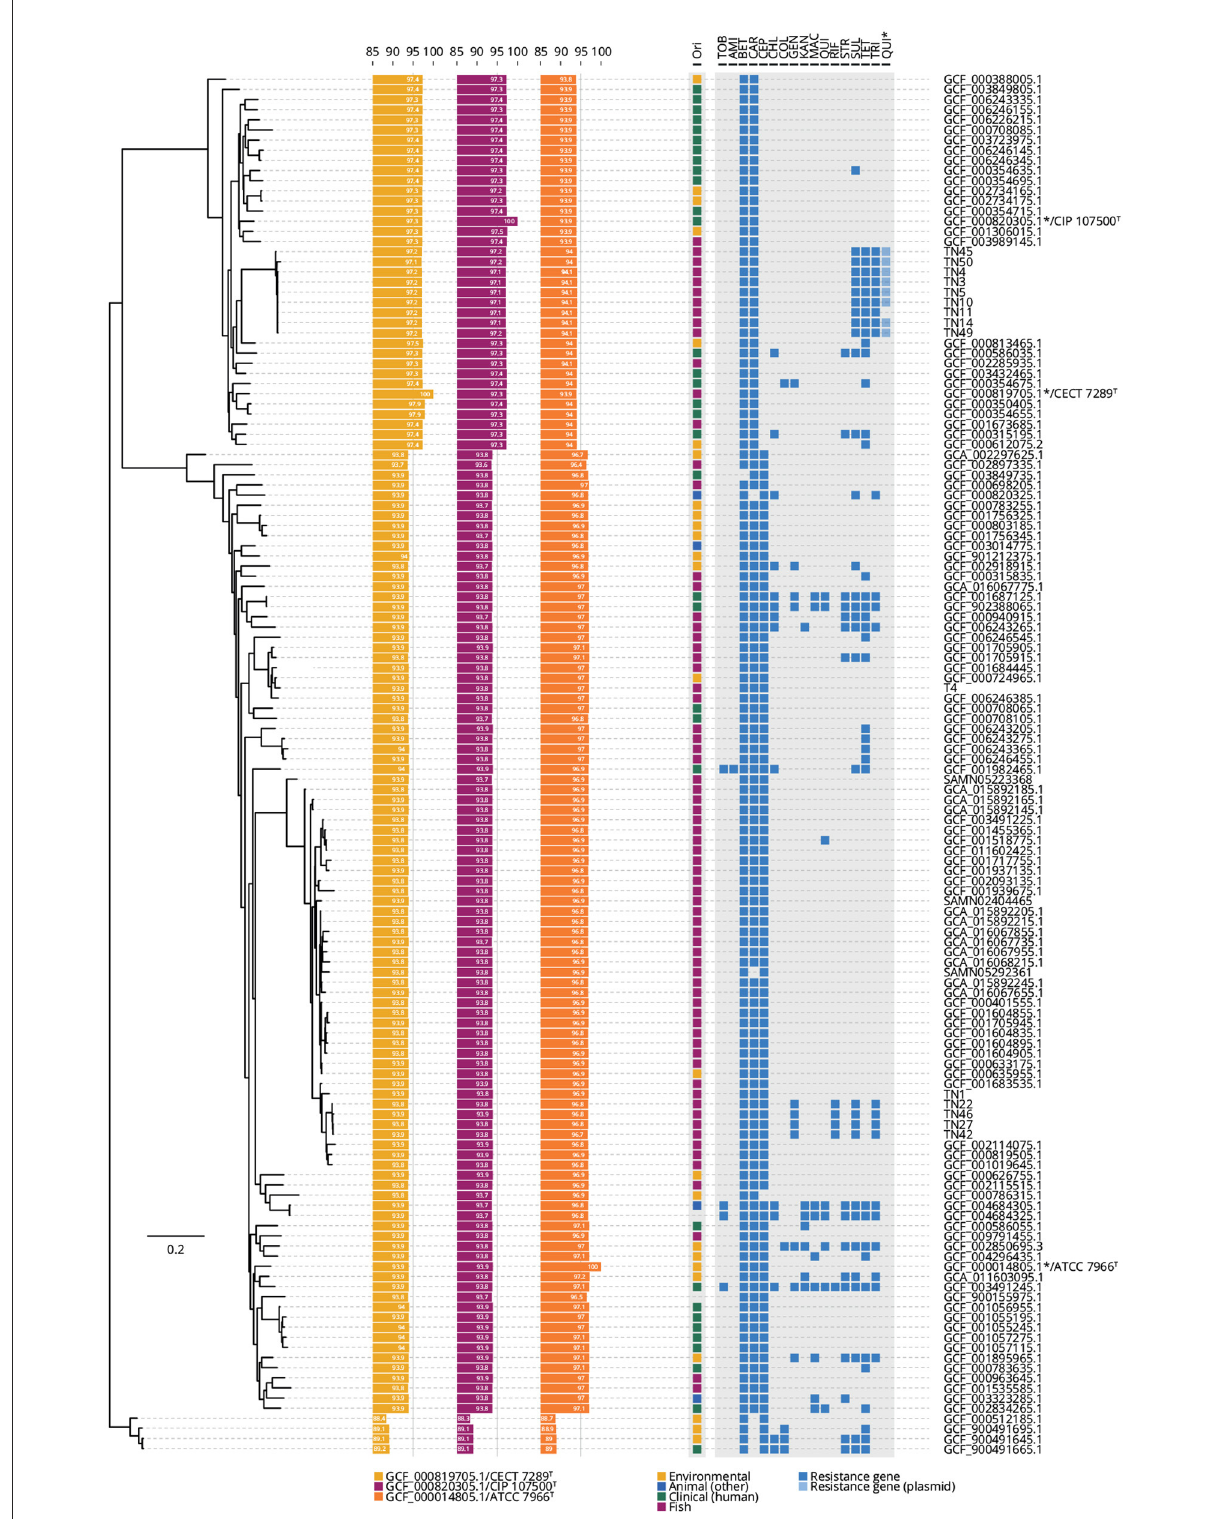
FIGURE2 Phylogenetic tree of 14 field isolates, one reference isolate, and 116 published A. hydrophila and A. dhakensis genomes. Four Aeromonas spp. genomes are included in the analysis as an outlier group. Tree is based on the pan-genome analysis. Average nucleotide identity (ANI)